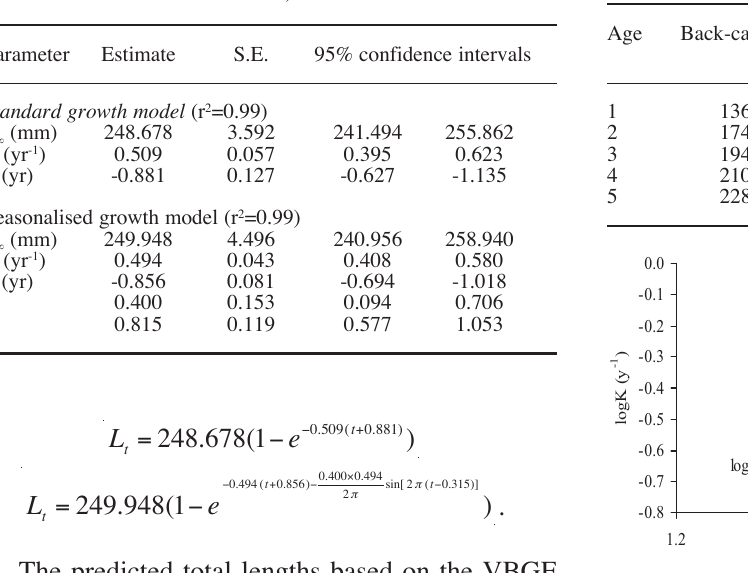
T ABLE 4. – Parameters estimates, standard errors (S.E.) and 95% confidence intervals for the standard and the seasonalised von Bertalanffy growth models for round sardinella, Aegean Sea (2000- 2002).